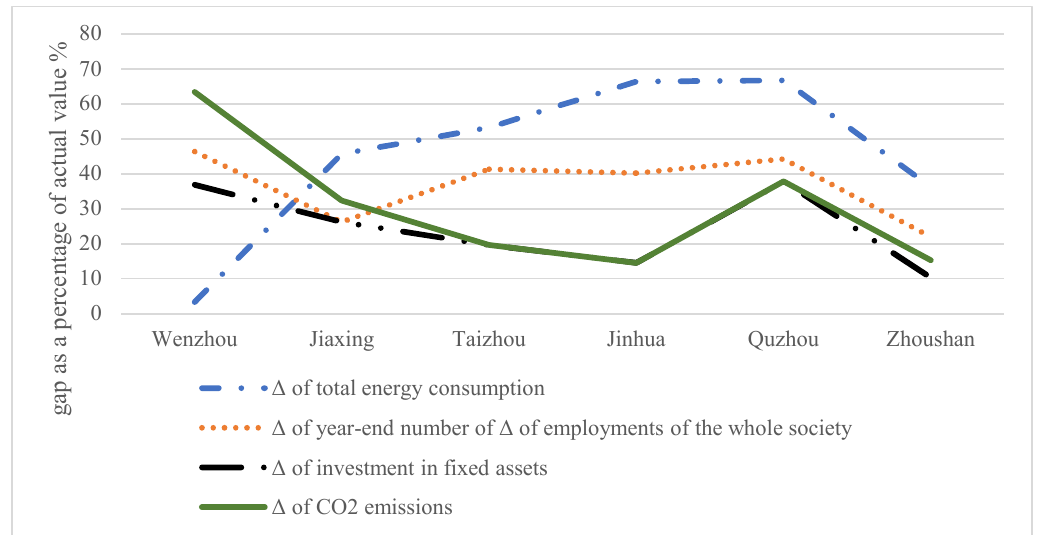
Figure 2. The reduction percentage ( ∆ ) of each prefecture-level city by projection.